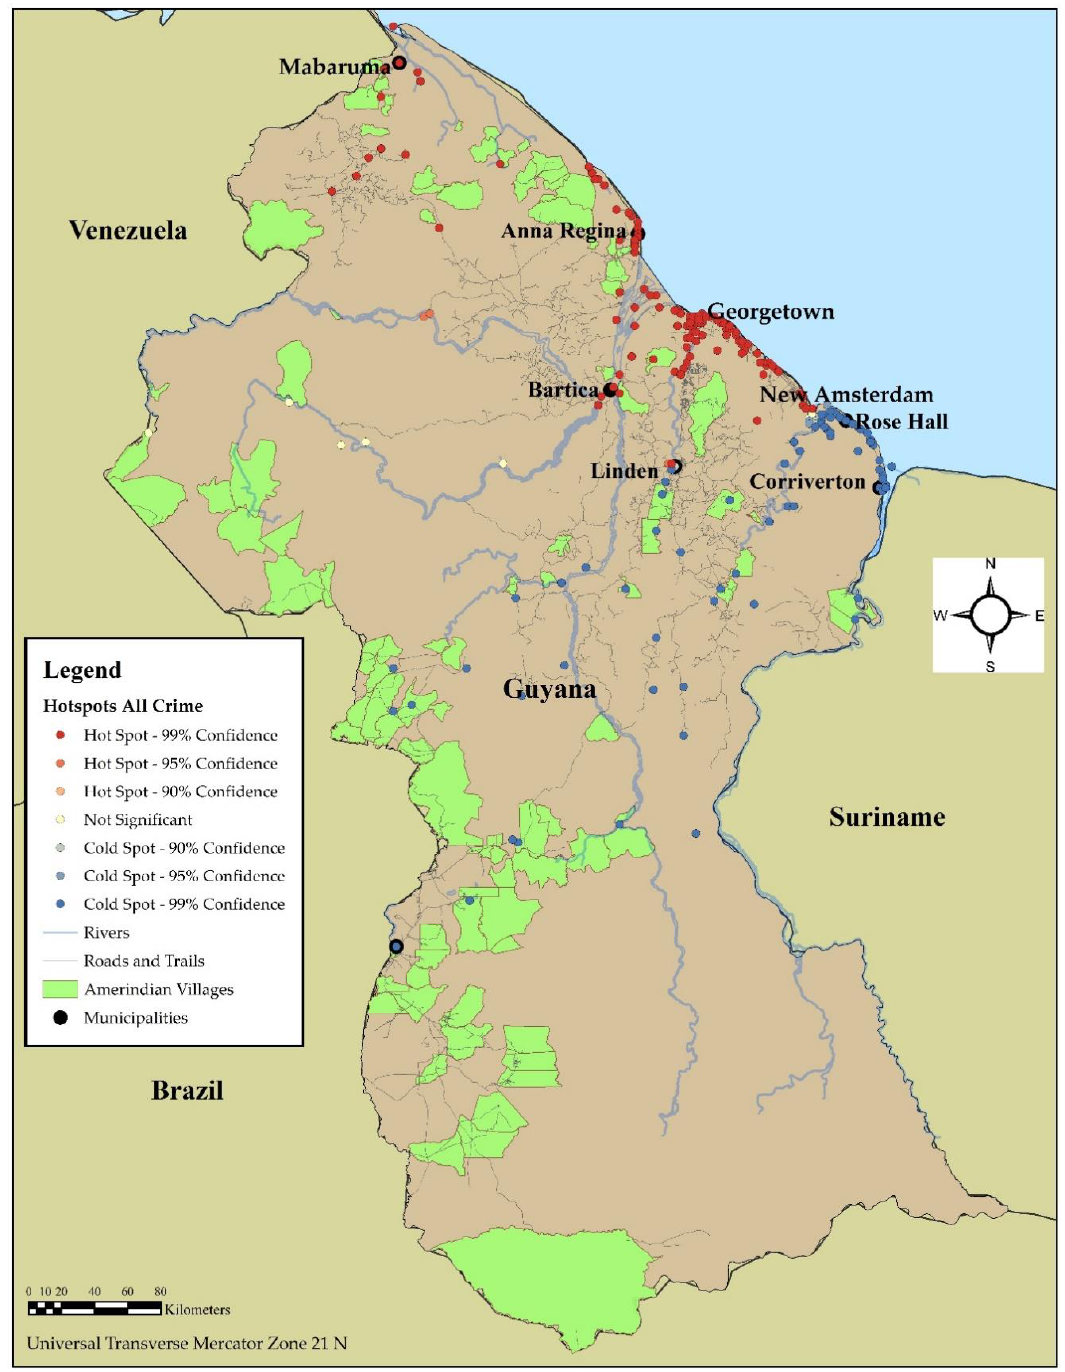
Figure 2. A hotspot analysis of violent crime in Guyana from 1986 – 2010.